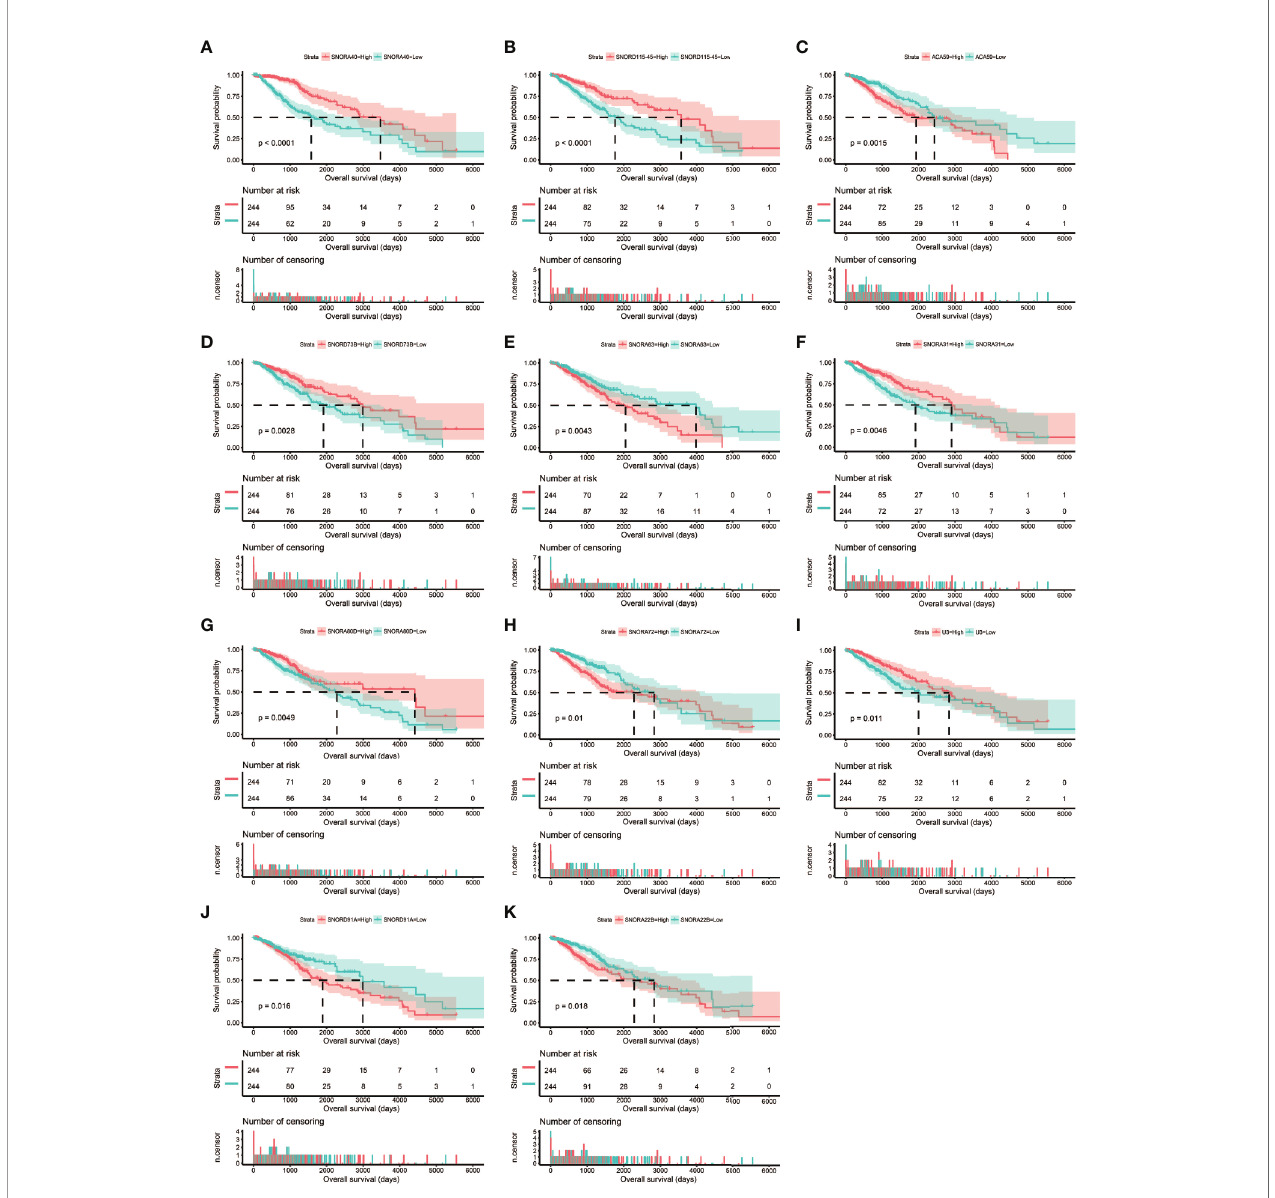
FIGURE 2 | Kaplan – Meier survival curves of 11 snoRNAs that constitute the prognostic signature. SNORA40 (A) , SNORD115-45 (B) , ACA59 (C) , SNORD73B (D) , SNORA63 (E) , SNORA31 (F) , SNORA80D (G) , SNORA72 (H) , U3 (I) , SNORD91A (J) , ANORA22B (K)